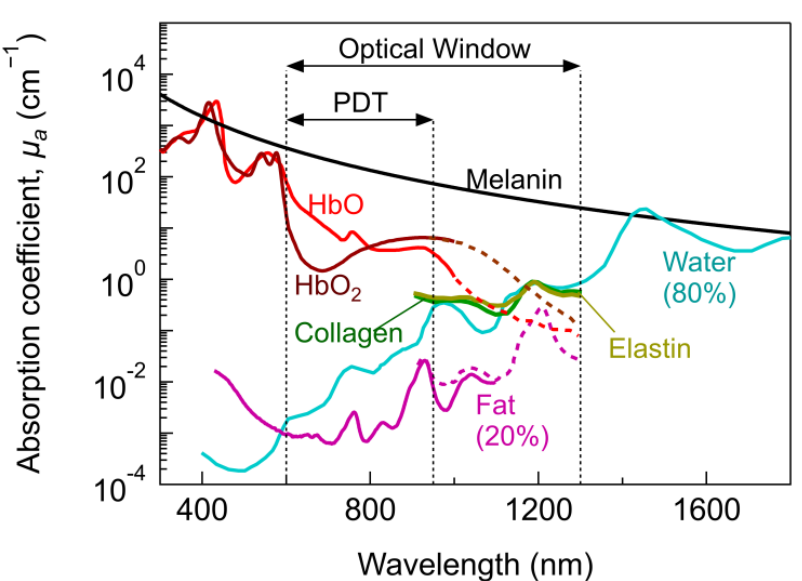
Figure 1. Absorption coefficient as a function of wavelength for several tissue constituents. Data for HbO (150 g/L), HbO 2 (150 g/L) and melanin are taken from [23]. Purified pig and human (dashed lines) fat from [24] and [25], respectively. Water from [26]. Collagen and elastin from [25]. HbO 2 and HbO shown as dashed lines are taken from [27] (adjusted to match the data at 1000 nm).